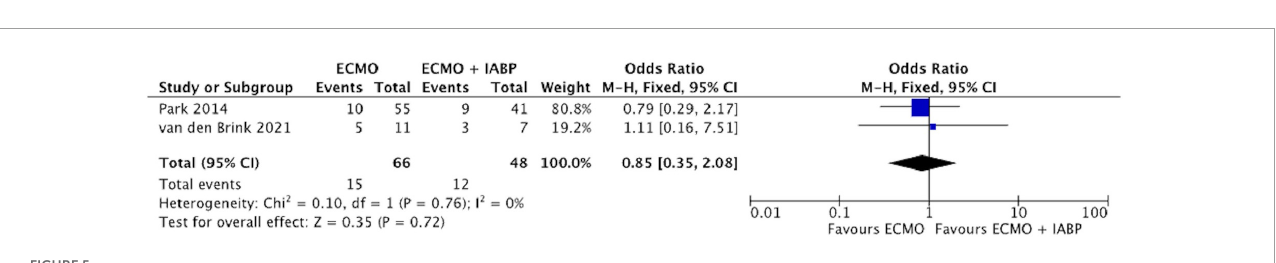
FIGURE5 Forest plot on vascular complications of ECMO + IABP vs. ECMO. Individual studies and pooled analysis showing no significant differences in the incidence of vascular complications for patients in cardiogenic shock due to acute myocardial infarction treated with ECMO + IABP compared to patients with ECMO only ( p < 0.001). CI, confidence interval; OR, odds